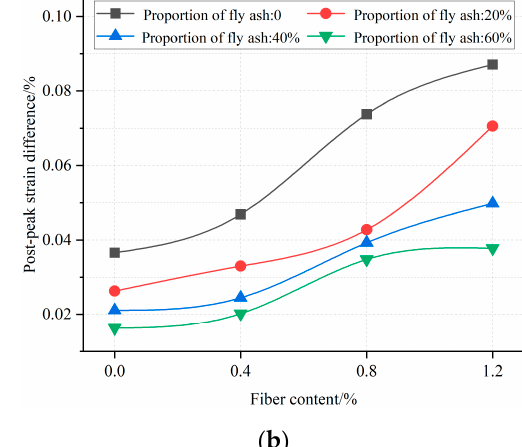
Figure 9 . Influence of the FA ratio ( a ) and SF content ( b ) on the post-peak strain difference.